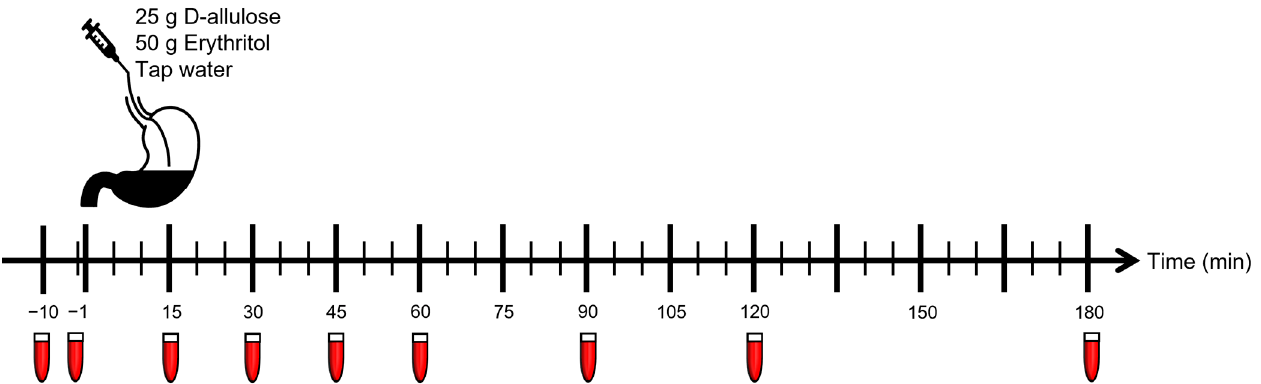
Figure 1. Study timeline: Intragastric administration of the solutions at t = 0 min to 18 healthy subjects in a randomized, double-blind, crossover order, in three different study visits after an overnight fast. The red tubes indicate blood sample collection.